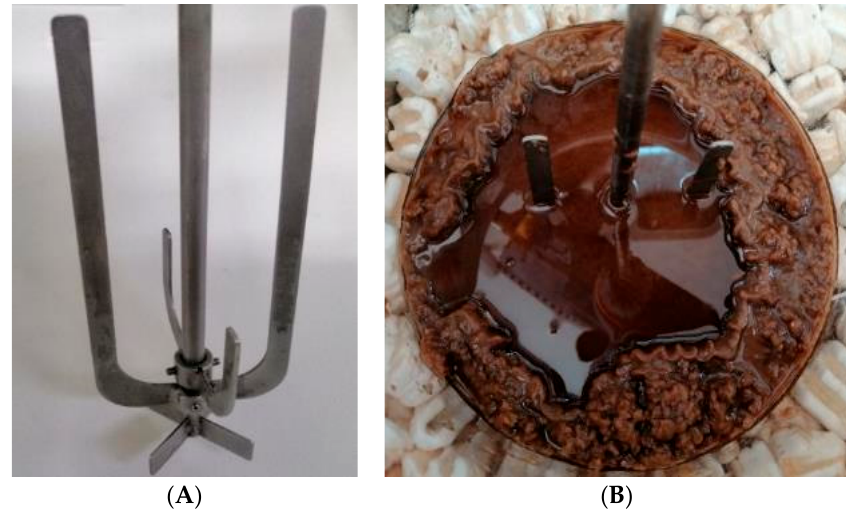
Figure 3. ( A ) Impeller configuration used in enzymatic hydrolysis experiments of the present work. ( B ) Initial liquefaction stage of the reaction medium during enzymatic hydrolysis of kraft pulp from Eucalyptus globulus bark.